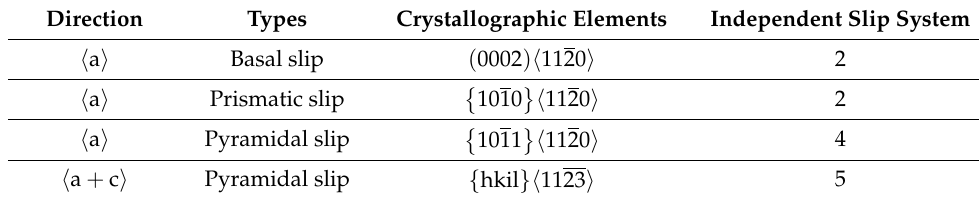
Table 3. Main slip systems and corresponding parameters of α -Ti [25].